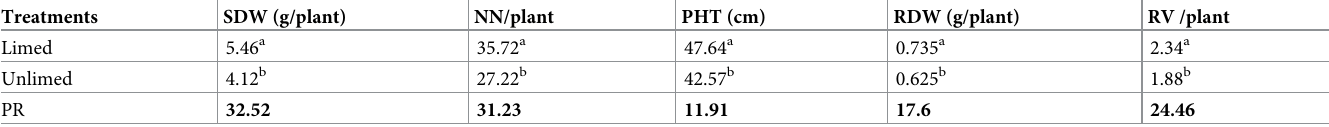
Means with the same letters are not significantly different at 5% level of significance. RDW- root dry weight; RV- root volume, SDW-shoot dry weight, PHT-plant height, NN-number nodule; PR = percent of reduction; CV- coefficient of